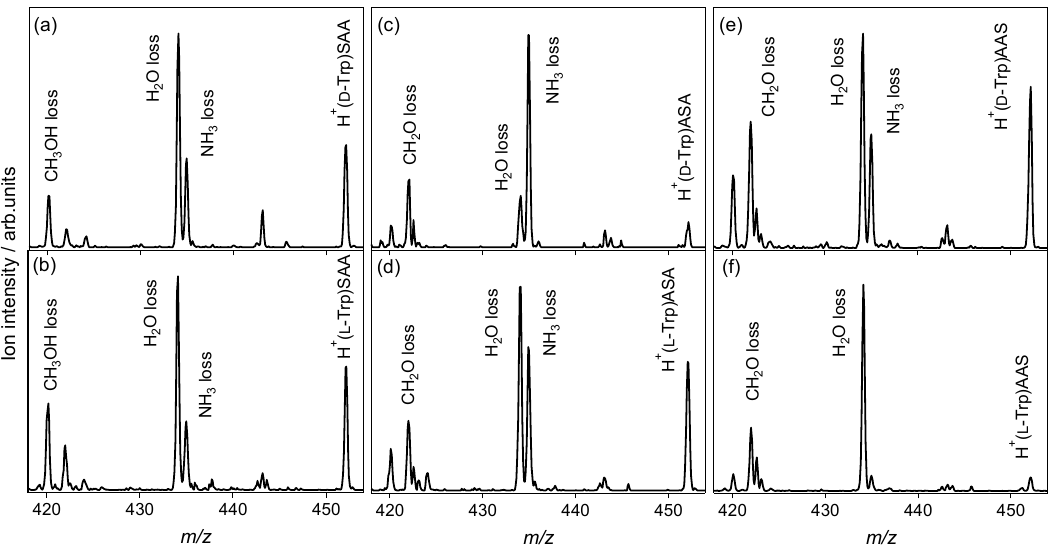
Figure 2. Collision-activated dissociation spectra of protonated noncovalent complexes of tryptophan with L -serine-containing tripeptides: ( a ) H + ( D -Trp)SAA, ( b ) H + ( L -Trp)SAA, ( c ) H + ( D -Trp)ASA, ( d )